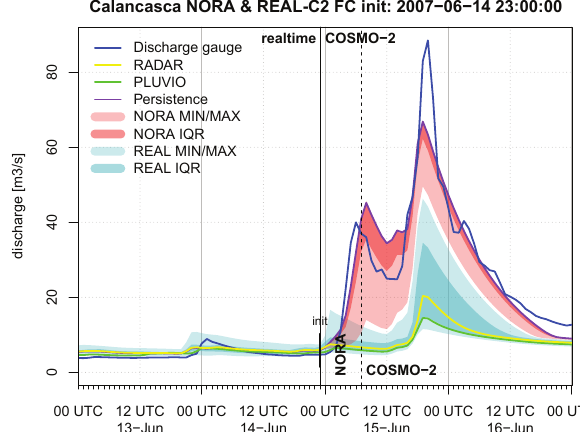
Fig. 7. Forecast simulation for the Calancasca initialised on 14 June 2007 at 23:00. At the time of the initialisation of NORA (vertical solid line), the nowcasts driven by REAL, RADAR and PLUVIO were connected to COSMO-2. After eight hours (vertical dashed line), NORA was also connected to COSMO-2. The analy- sis covers the eight hours covered by NORA forecasts, that is, the time frame between the vertical solid and dashed lines in the graph